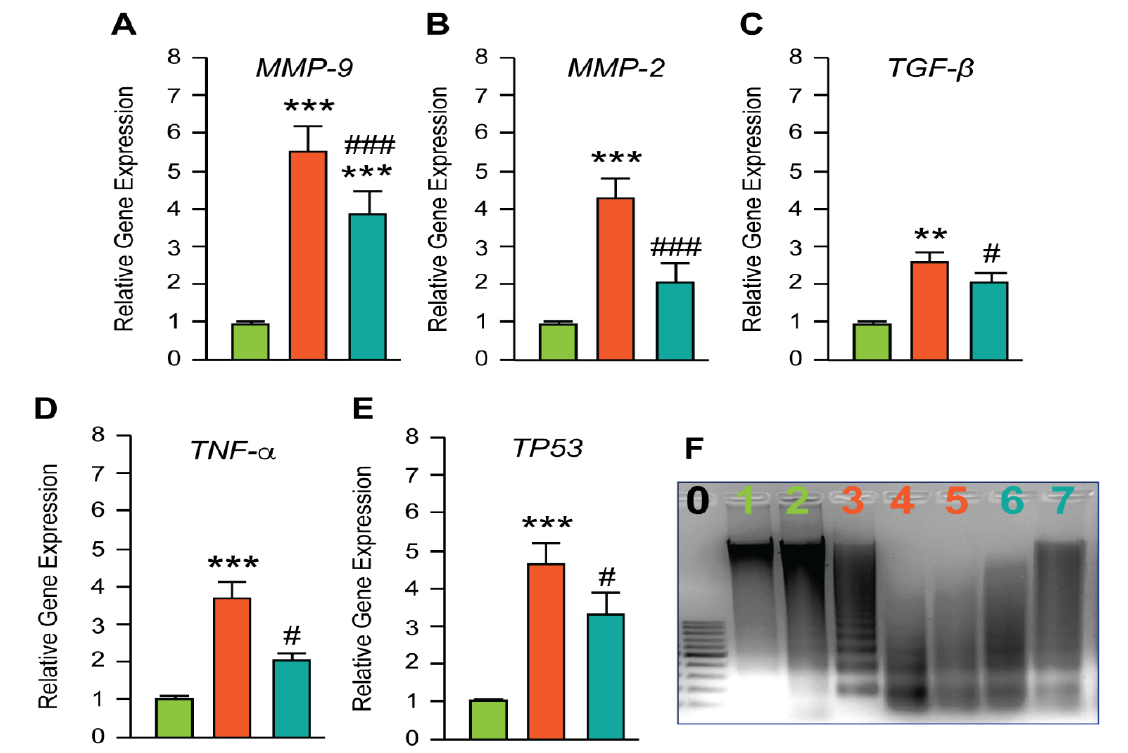
Figure 3. Studies investigating genes involved in inflammation and apoptosis. ( A – E ) Analysis of gene expression by quantitative RT-qPCR of MMP-9, MMP-2, TGF- β , TNF α , and P53 in aged rats treated for ten week with streptozotocin and polyphenol combination (NCQ). Data are reported as the fold change of control, following normalization with β -actin expression. ( F ) DNA fragmentation assay. Lane 1/2: DNA of control group. Lane 3/4/5 STZ group and 6/7 NCQ-STZ group. Data are expressed as means ± SEM. *** p < 0.001, ** p < 0.01, when the control group is compared to STZ-induced diabetic rats group; # p < 0.05, ### p < 0.001 when STZ-untreated rats are compared to NCQ-treated group.